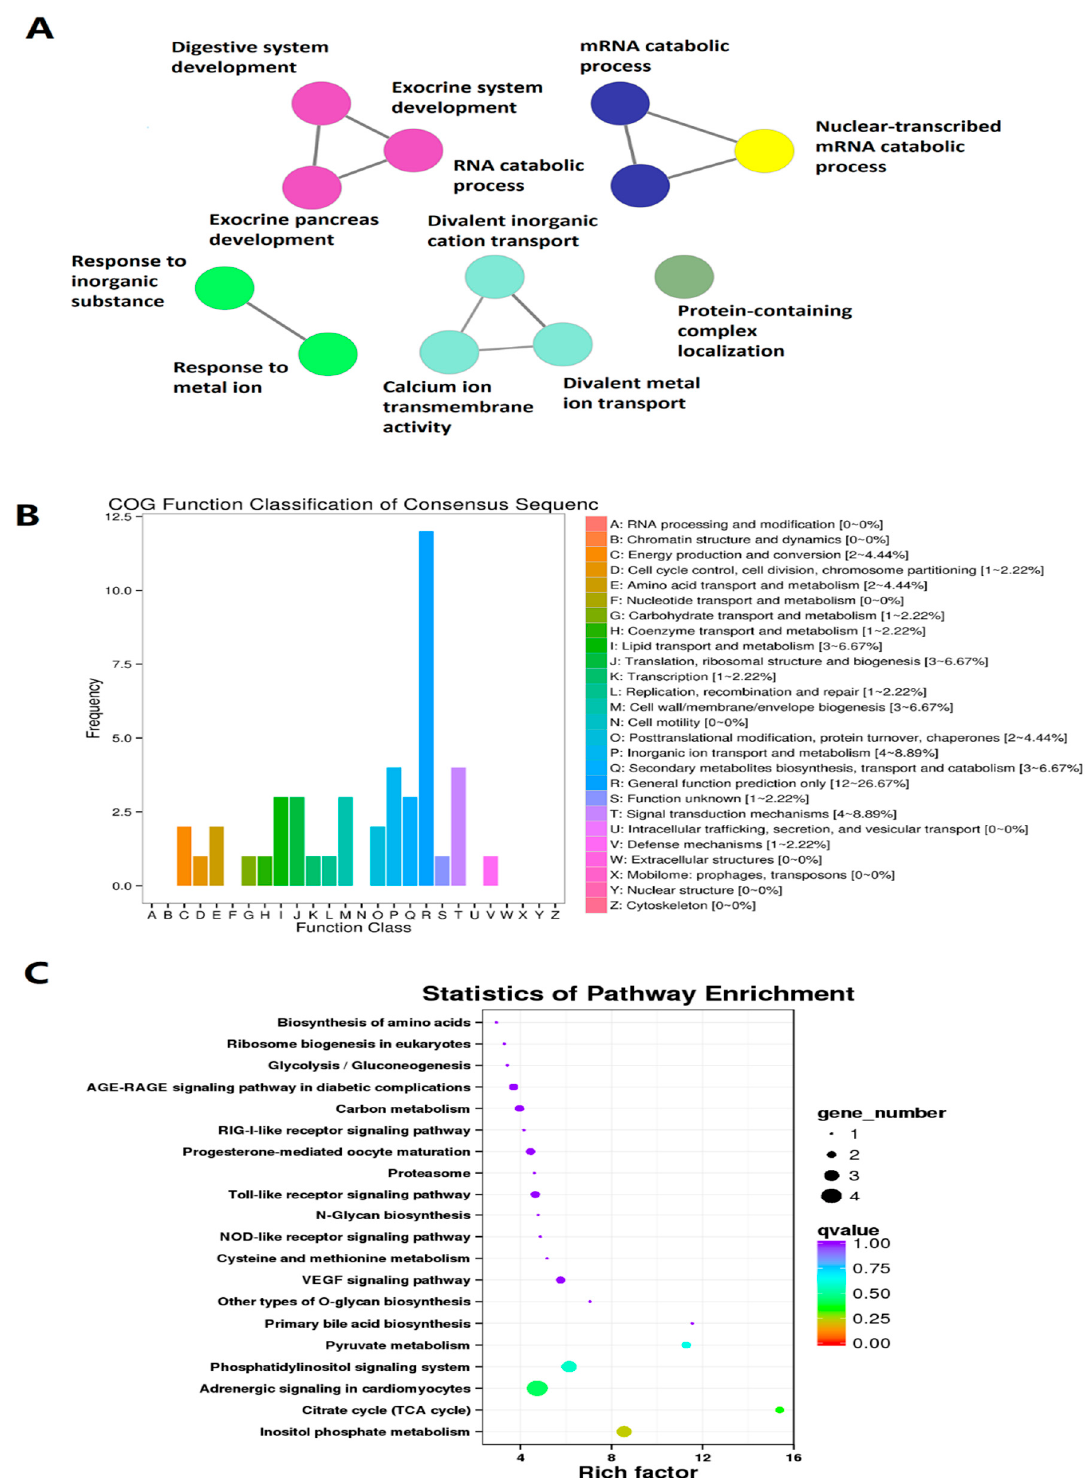
Figure 4. GO, COG, and KEGG analyses of circadianly expressed zebrafish larval lncRNAs under the DD condition. ( A ) GO annotation revealed the lncRNAs potentially involved in different biological processes, such as nuclear-transcribed mRNA catabolic process, and eye photoreceptor cell differentiation. ( B ) COG functional classification of circadianly expressed larval lncRNAs under the DD condition. ( C ), KEGG pathway enrichment analysis of circadianly expressed lncRNAs under the DD condition.